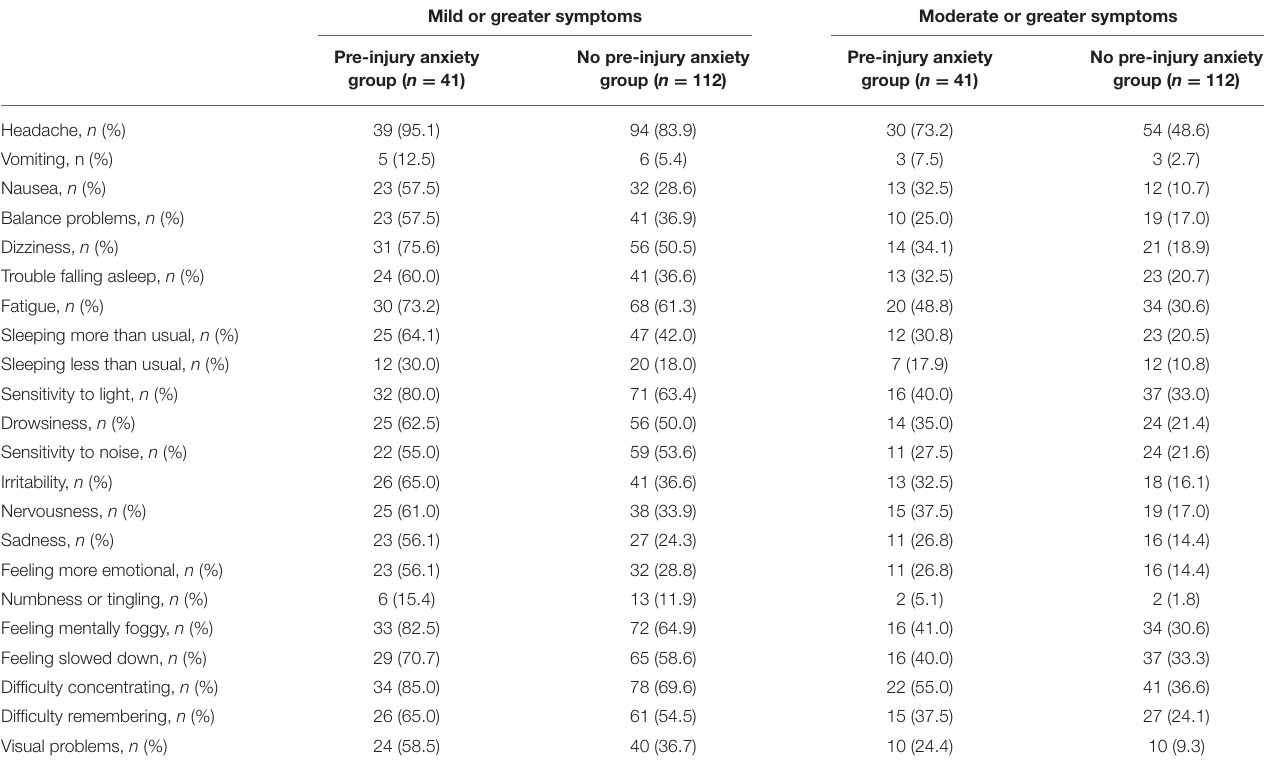
TABLE 2 | Endorsement of individual symptoms stratified by a personal history of treatment for anxiety.